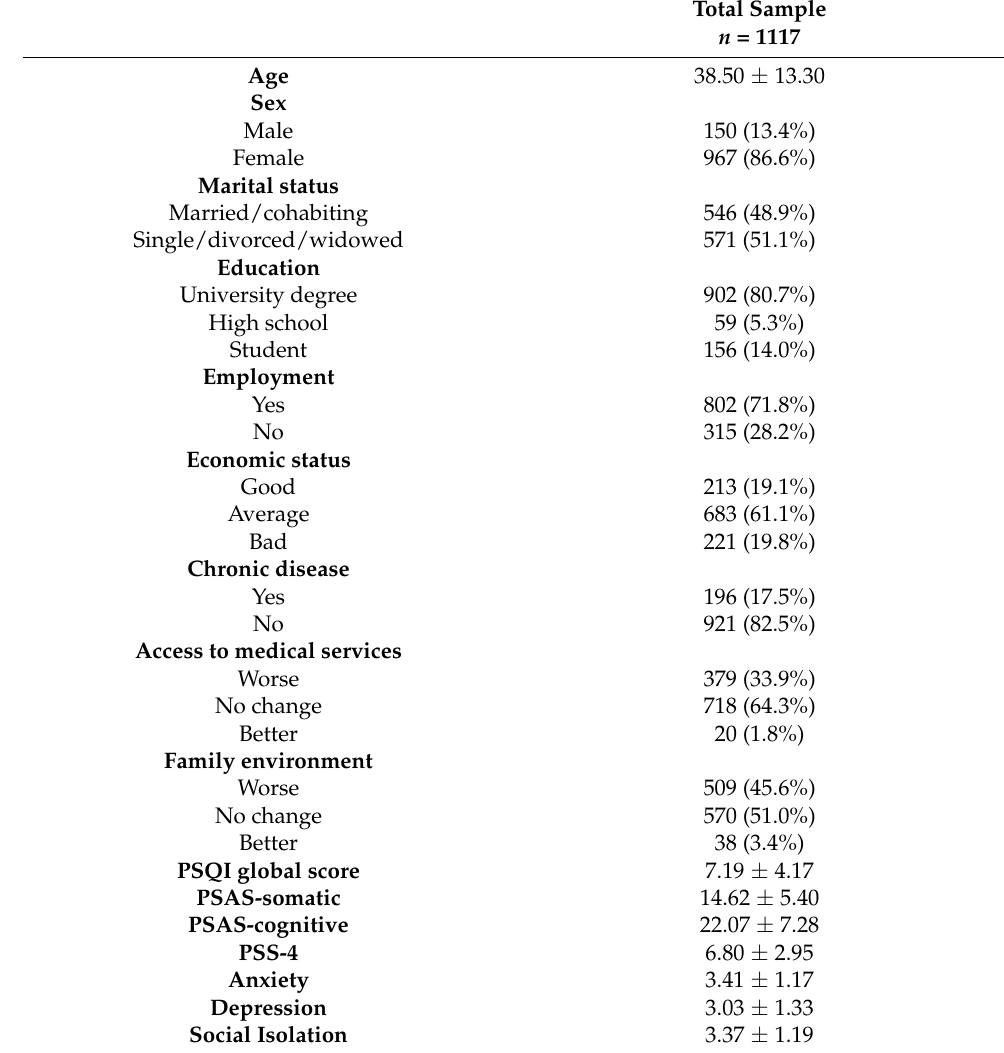
Table 1. Demographic, health, and psychosocial variables of the study